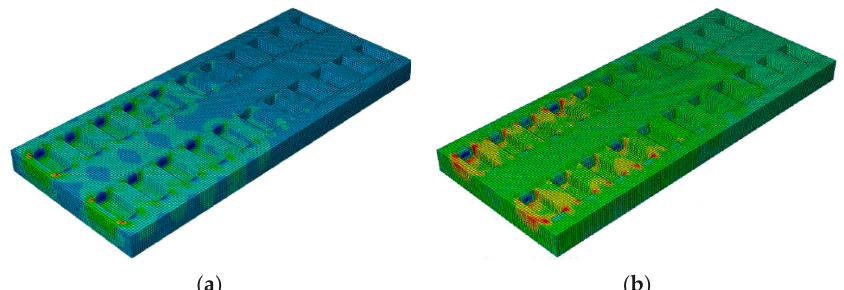
Figure 28. Stress cloud diagram of track bed under vertical load. ( a ) Track bed of TLVT. ( b ) Track bed of ILVT.